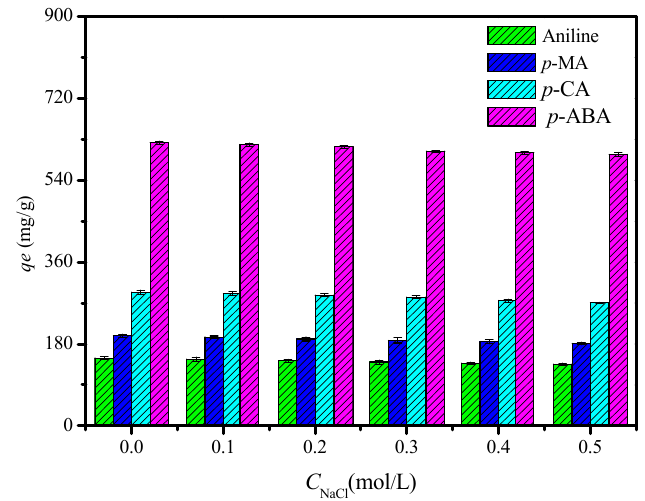
Figure 6. Influence of NaCl concentration on aniline removal using the CDM-HCP as adsorbent.